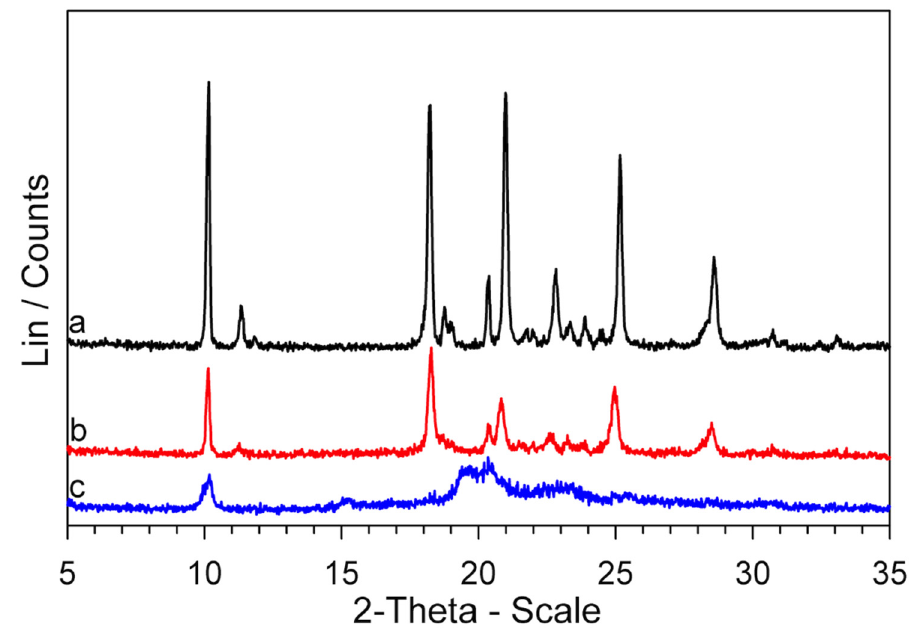
Figure 10. XRPD patterns of GS * ( a ), (cid:1833)(cid:1842)(cid:1852) (cid:2870)(cid:2873)(cid:2868)(cid:2869)(cid:2876)(cid:2868) ( b ), and GPZ 250 ( c ) samples. It seems clear that: (a) GPZ 250 is mainly amorphous; (b) heating this sample up to 180 °C ( (cid:1833)(cid:1842)(cid:1852) (cid:2870)(cid:2873)(cid:2868)(cid:2869)(cid:2876)(cid:2868) ) causes an at least partial crystallization; (c) the diffraction peaks of (cid:1833)(cid:1842)(cid:1852) (cid:2870)(cid:2873)(cid:2868)(cid:2869)(cid:2876)(cid:2868) show a lower intensity but they have the same angular positions of those of the GS *